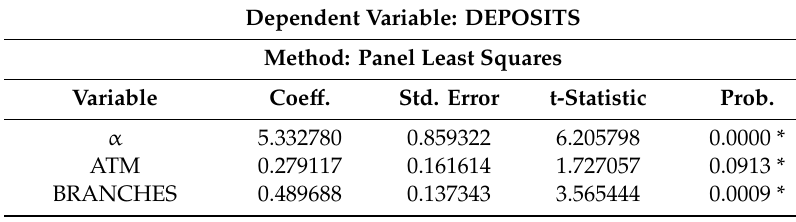
Table 1. Panel data results (Equation (1)).